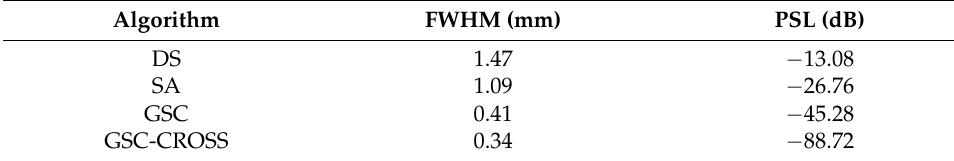
Figure 4. Lateral variation of point at ( a ) z = 35 mm; ( b ) z = 40 mm.